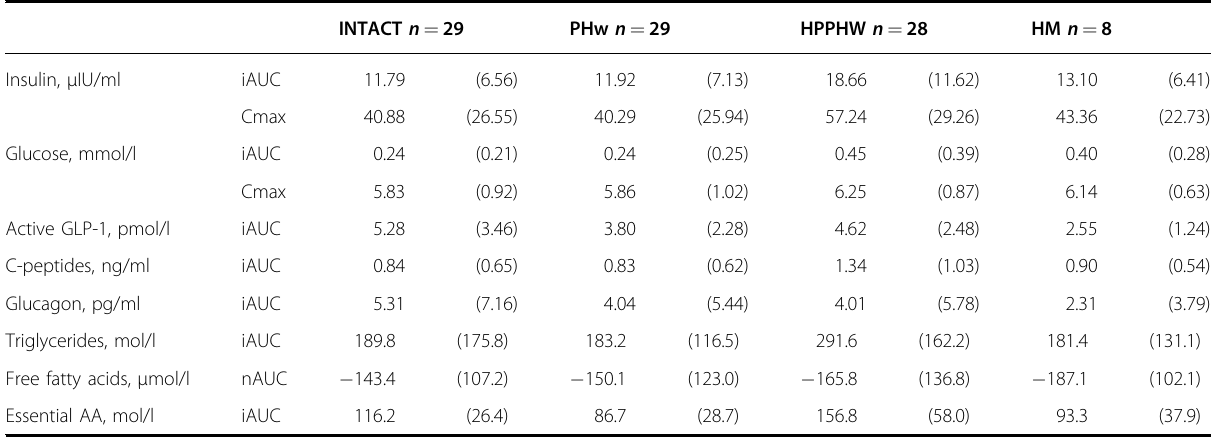
Table 3 Metabolic responses to infant formulas, varying in type and quantity of protein, and human milk.